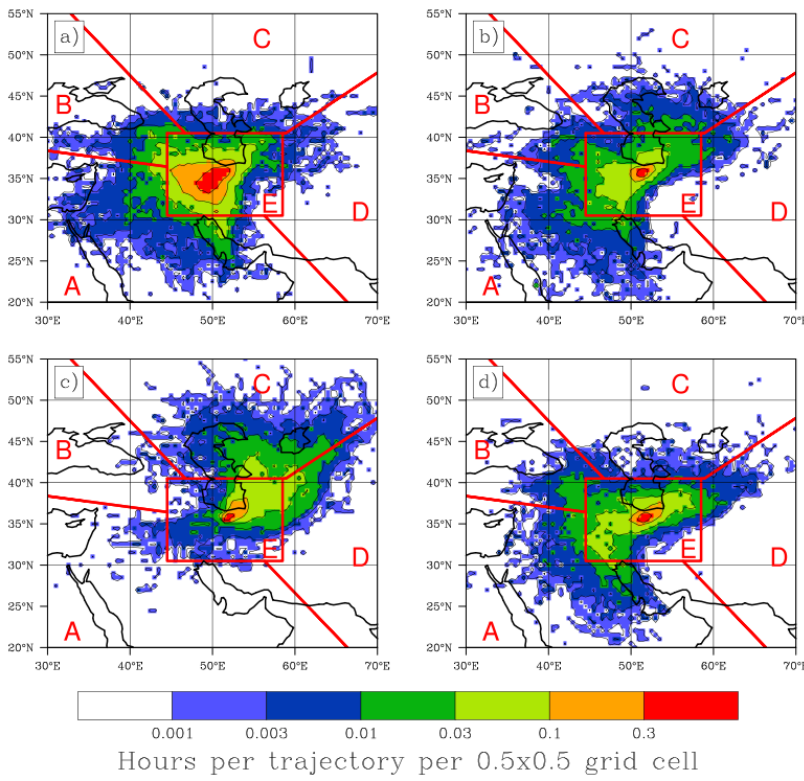
Figure 4. Decadal (2000–2009) summary of seasonal HYSPLIT five-day back-trajectory frequencies, ending at 500m above Tehran (35.70°N, 51.42°E) for ( a ) winter (DJF), ( b ) spring (MAM), ( c ) summer (JJA), and ( d ) fall (SON). Frequency is defined as the number of trajectory-hours spent in each 0.5° × 0.5° grid box divided by the total number of trajectories analyzed. Source regions, as illustrated in Figure 3, are